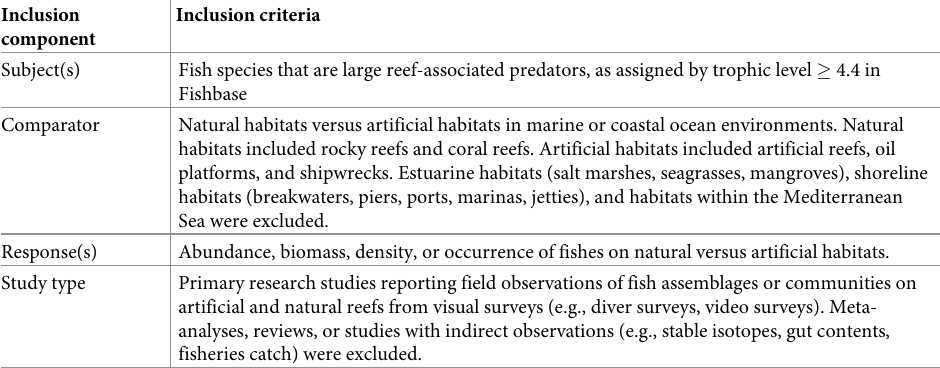
Table 2. Study inclusion components and criteria for literature review of fish occurrence on artificial versus natu- ral reefs. Inclusion